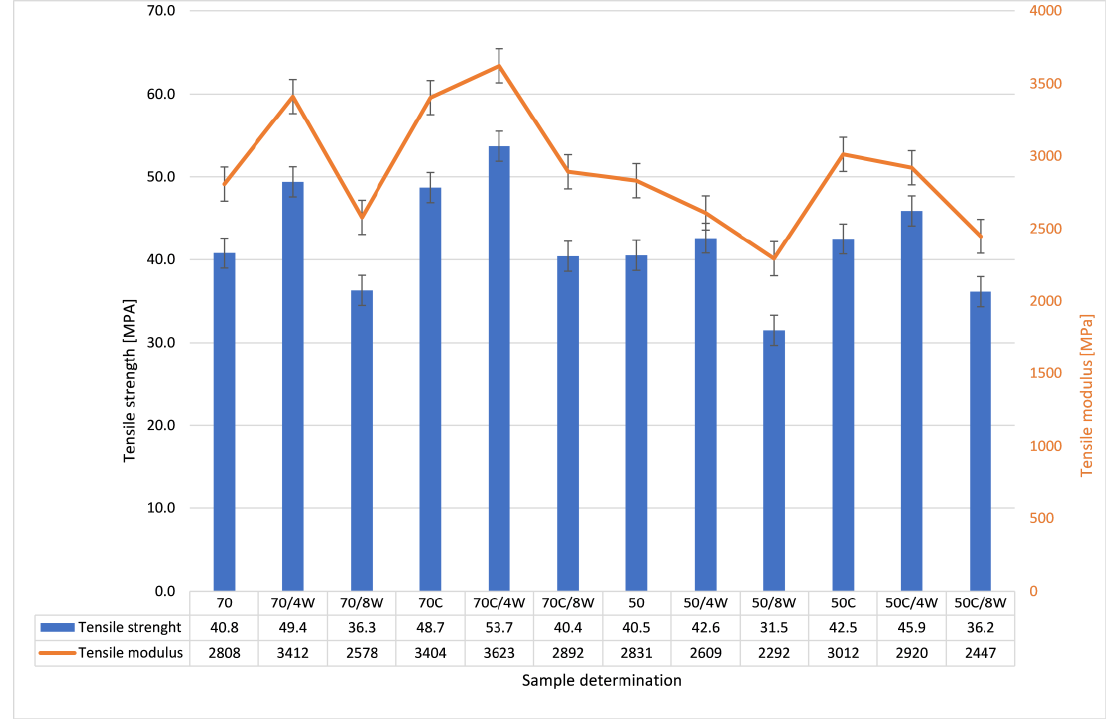
Figure 6. Comparison of mechanical properties examined during static tensile tests conducted at room temperature for pure, hydrolytically biodegraded and crystallized samples.